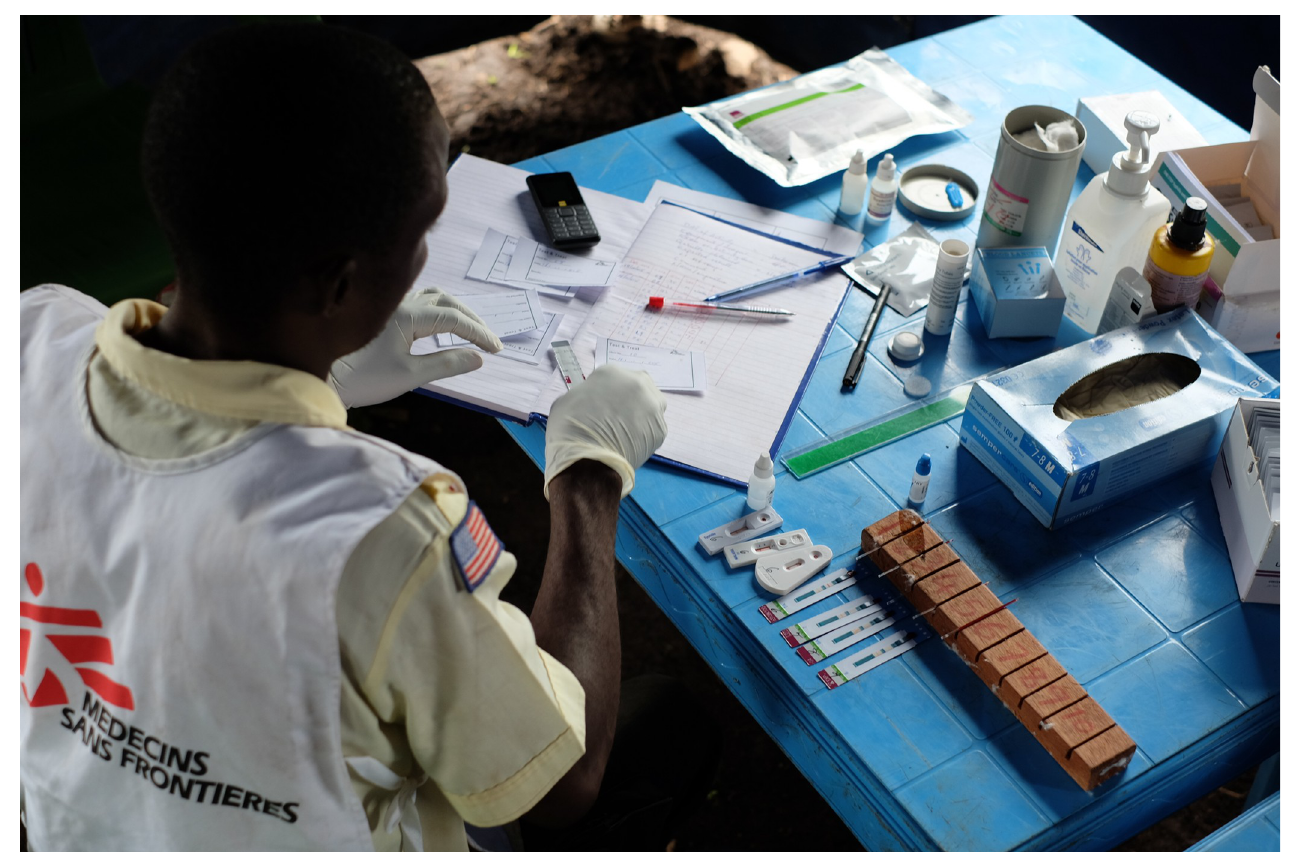
Fig 2. Rapid diagnostic testing for HIV, CD4 and viral load at community